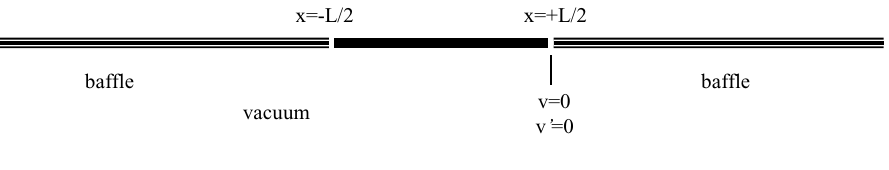
Fig. 3. Simply supported strip